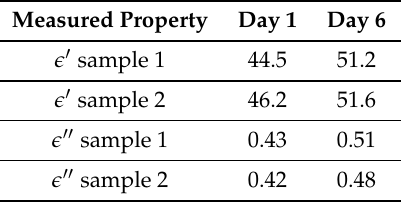
Table 2. Dielectric properties of brain phantoms over time at 1 GHz.